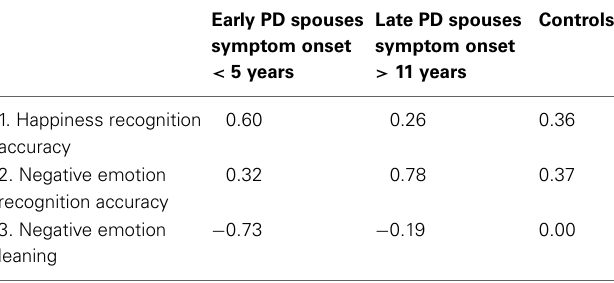
Table 4 | Mean values of happiness and negative emotion recognition accuracy, as well as negative emotion leaning, among spouses of PD patients vs. controls as a function of years from PD symptom